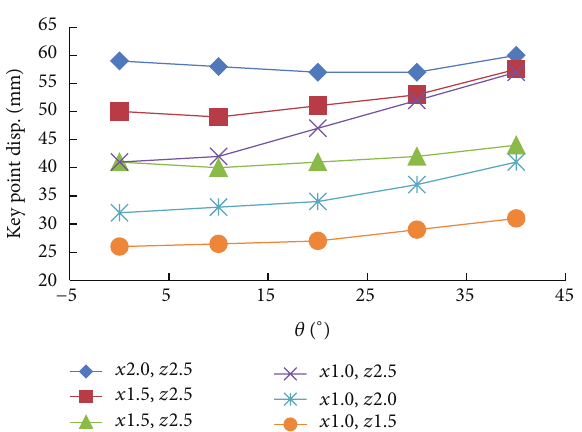
Figure 27: Splitting zone volume versus 𝜃 in case 2